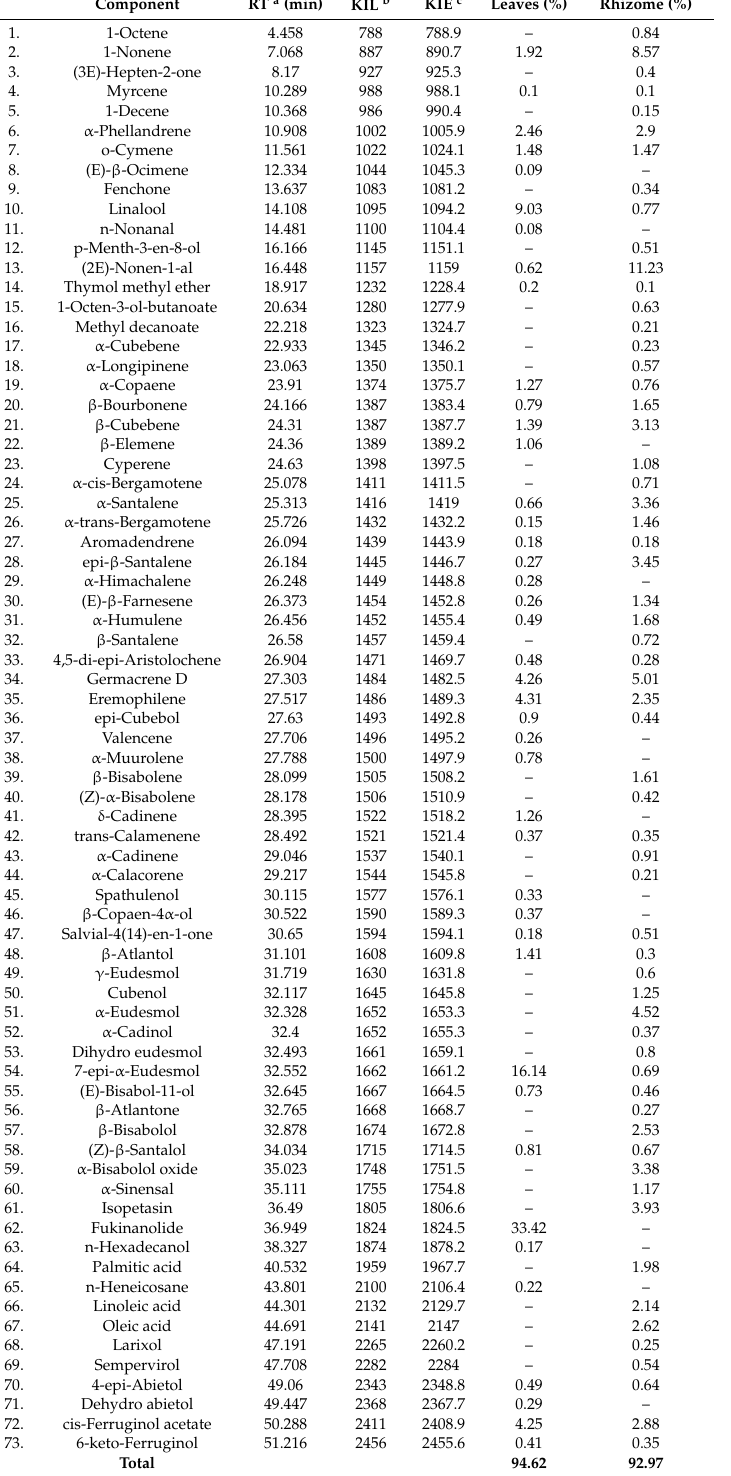
Table 1. Chemical composition of the essential oils of Petasites hybridus subsp. ochroleucus extracted by hydrodistillation from rhizome and